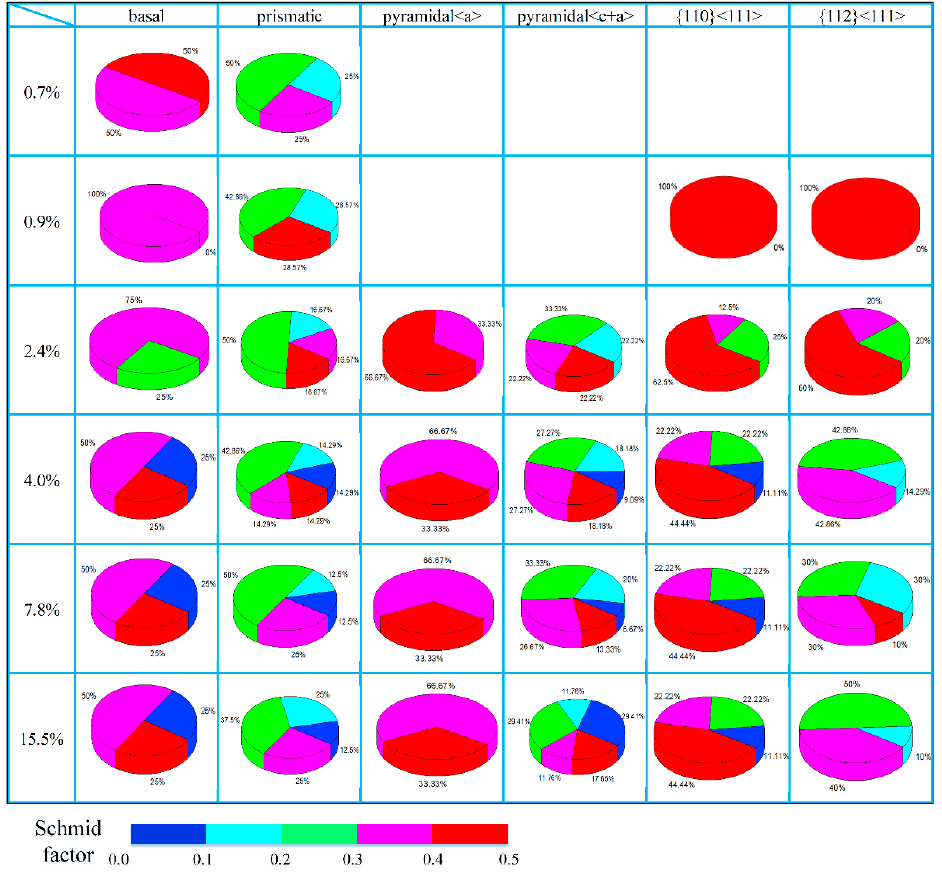
Figure 13. Distribution of recalculated SFs at macro strains = 0.7%, 0.9%, 2.4%, 4.0%, 7.8%, 15.5%.